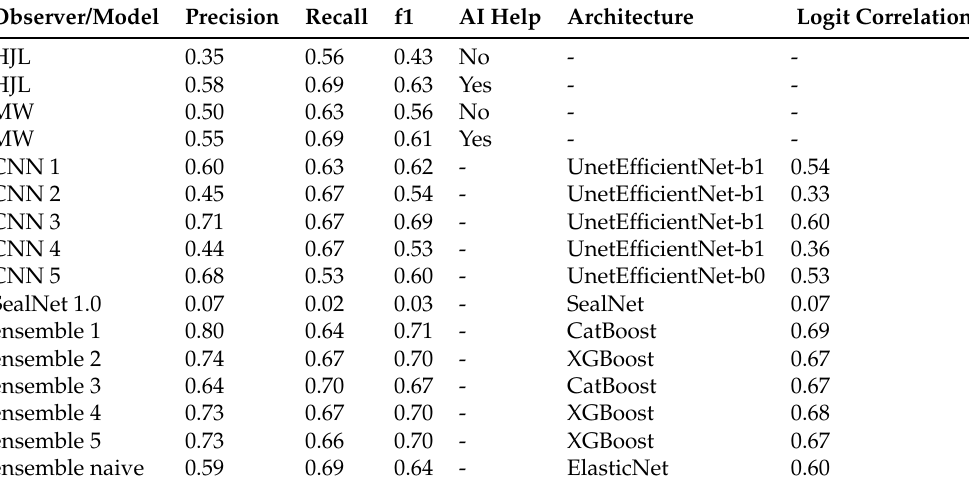
Table 1. Out of sample performance for human observers (with and without the help of AI output), individual CNN models, and model ensembles measured at the random crops tests set. AI help is provided through the output of a simple ensemble model (i.e., an ElasticNet classifier, ‘ensemble naive’), with a color gradient based on model certainty. Because whether an observer will have access to AI help is assigned independently at random, human observers had different sets of imagery processed with the aid of AI output. U-Nets 1–5 are ordered according to their ranking based on f1-score in the expert-selected test set. SealNet 1.0 predictions were obtained with the original SealNet. Similarly, ensemble models 1–5 are numbered in descending order of f1-score on the validation portion of the random crops test set. We include the correlation between model logits and ‘truth’ labels as a measurement of